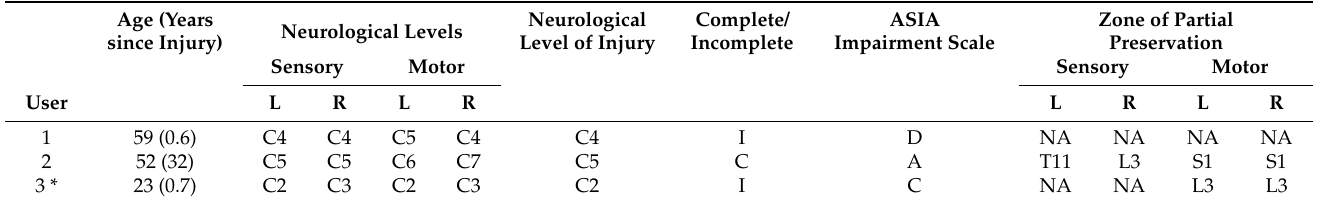
Table 3. ISNCSCI assessment of users. Summary ratings of the ISNCSCI assessments for each user who participated in the study. * Indicates that the user used a